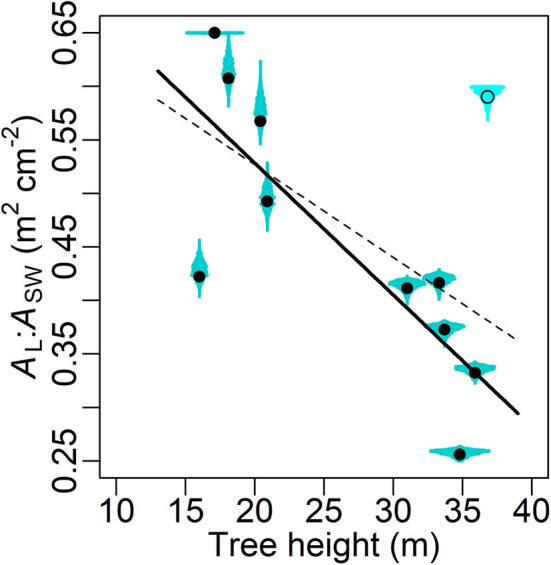
Maxima a posteriori (MAP) estimates (circle) of leaf-sapwood area ratio (AL:ASW in m2 cm−2, i.e. ρ × 10−4; Table 3B) with posterior distribution (cyan shade) in relation to tree height. The dashed and solid lines, respectively, are linear fittings with and without an outlier (Cook's distance = 0.69 when used in the linear regression), which is marked by the empty circle with the shade in lighter colour. The fittings' forms y = −0.0087 x + 0.700 and y = −0.0123 x + 0.774, R2 = 0.339 and 0.657, P = 0.06 and 0.004, respectively.